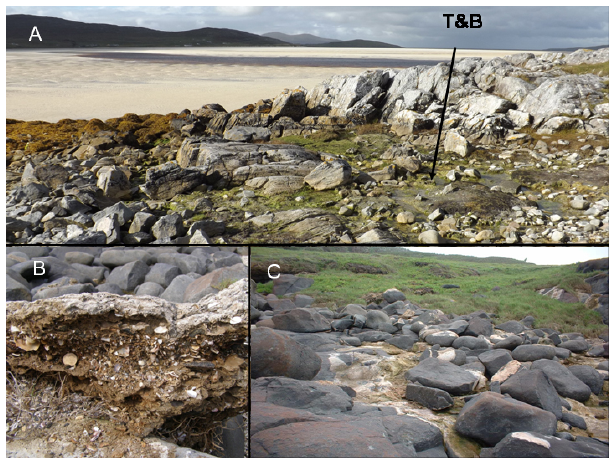
Figure 2. (a) Shore platform showing a low tufa curtain (T), bar- rage (B), and pool (BP). (b) Higher tufa curtain (T) forming on a cliff at the back of the dolerite shore platform with stromatolites (S) at its toe ( a and b from Cape Morgan), and (c) Tufa curtain from Northton, Harris, UK. Here there is no shore platform.